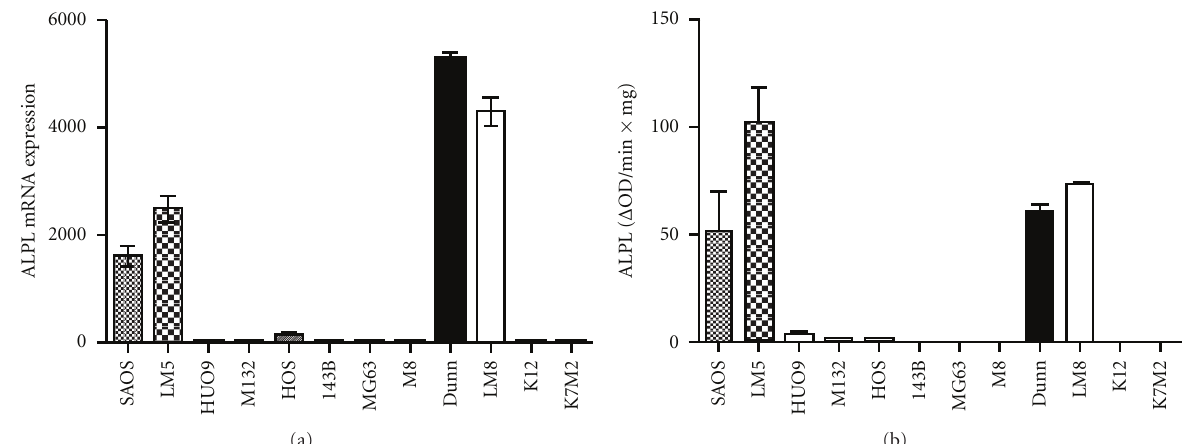
Figure 2: (a) RMA normalized ALPL (human: 215783 s at; mouse: 1423611 at) mRNA expression. (b) ALPL enzyme activity. TPM1, HAPLN1, and ACTA2 were present among the common regulated genes. Likewise, we identified MEIS2 (targets ETV1, PAX3, PAX6) to be significantly active. This transcription factor has not been associated to OS metastasis before, but was earlier found to be regulated in lung cancer [29], ovarian cancer [30], thyroid cancer [31], and prostate cancer